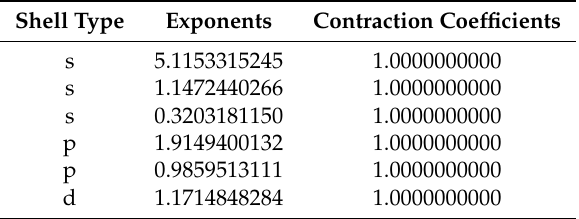
Table A16. Parameters of the cc-DZVP auxiliary basis set of Hydrogen. Parameters taken from [89].